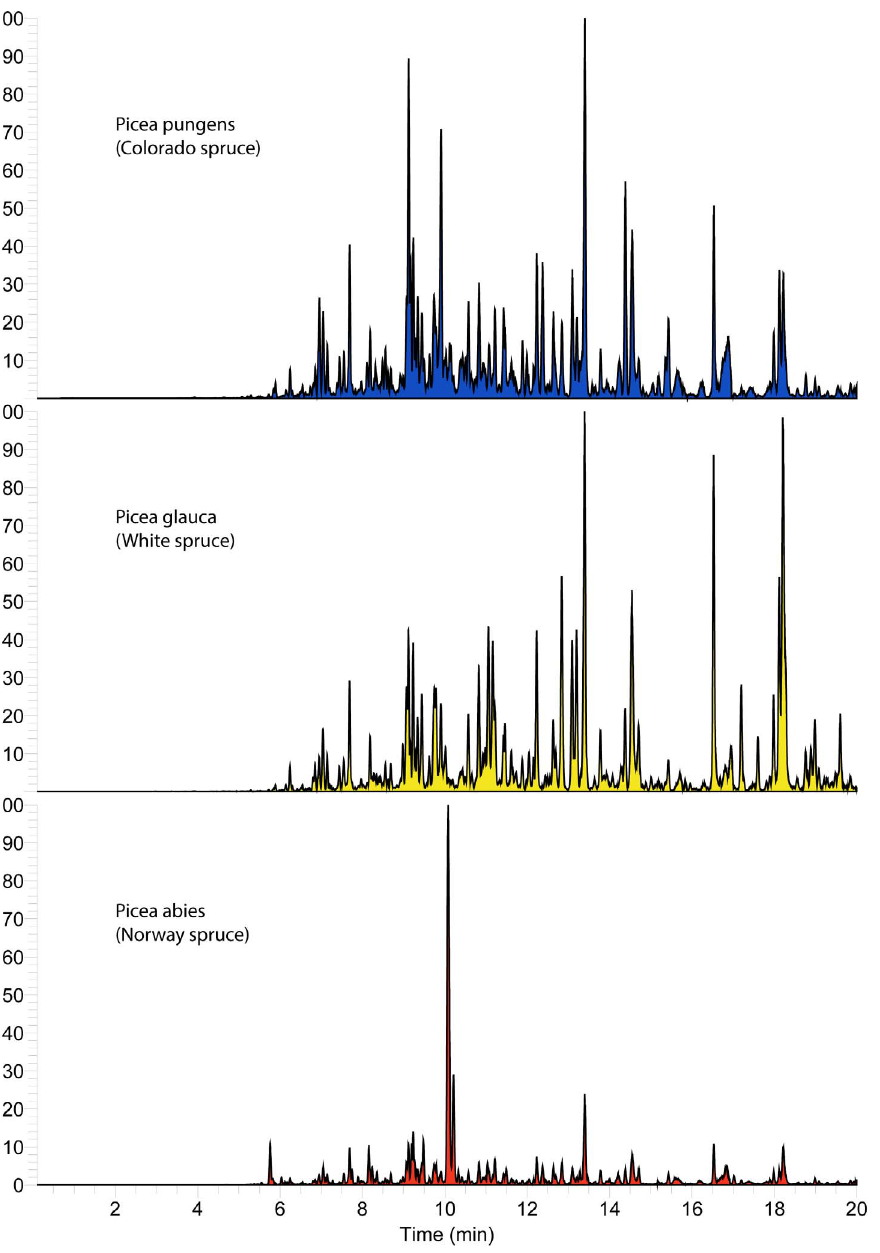
Figure 4. Resin metabolite diversity of studied Piceasp . (Spruce). Base-peak negative-ion chromatogram (‘‘fingerprints’’) of resin collected from individual Picea spp . within 2 miles of the study apiary.